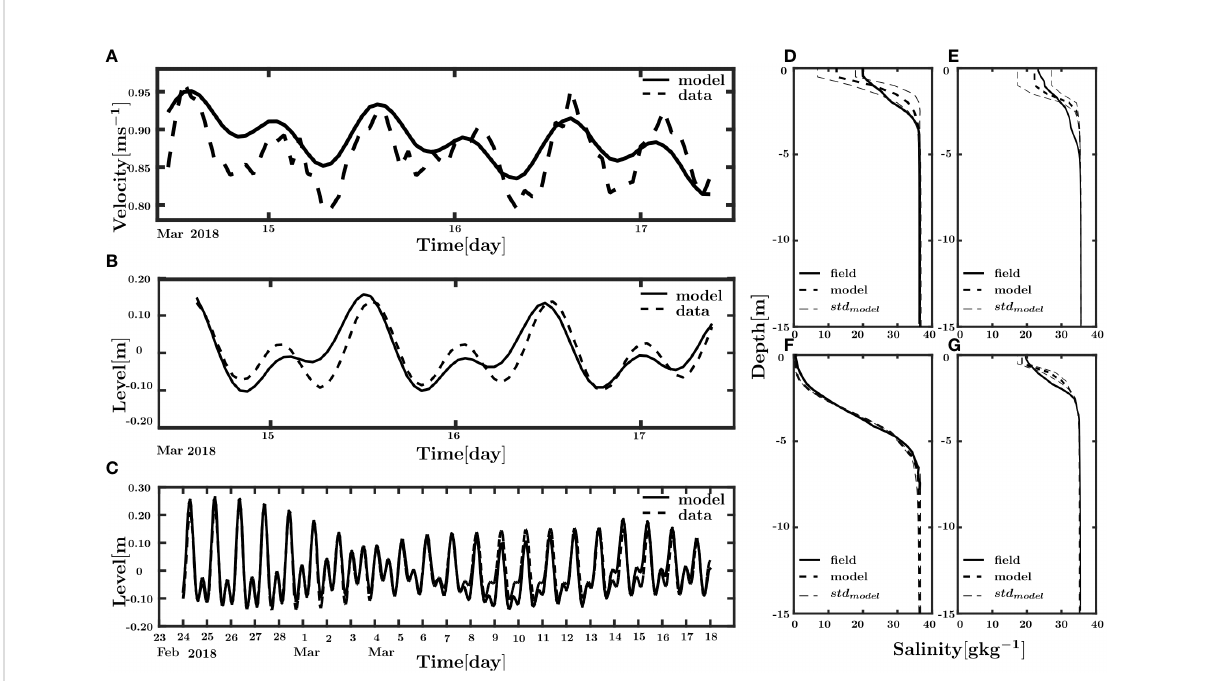
FIGURE 2 Measured and simulated time series of (A) velocity at point P2. (B) Water level series at point P2. (C) Water level series at point P3. (Including spring and tidal conditions). Comparison of salinity pro fi les considering wave-current interaction at the. (D) North-west (02-28-2018). (E) North- east (02-28-2018). (F) Mouth (02-28-2018 and 02-03-2018), and (G) North (03-01-2018) zones of the